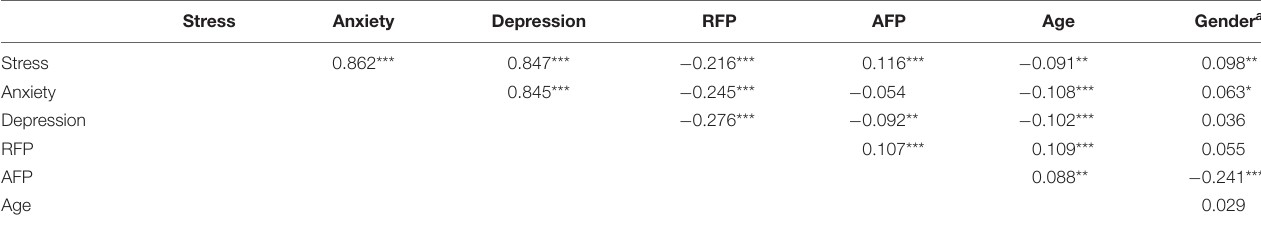
TABLE 3 | Zero-order correlations between continuous study